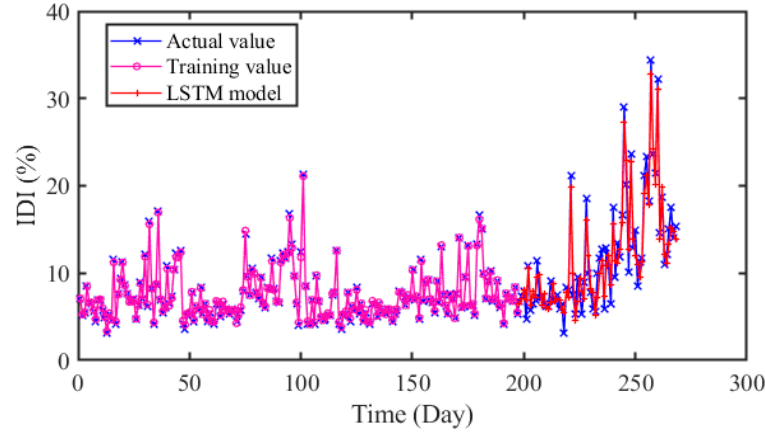
Figure 13. The predicted results of CNN model .